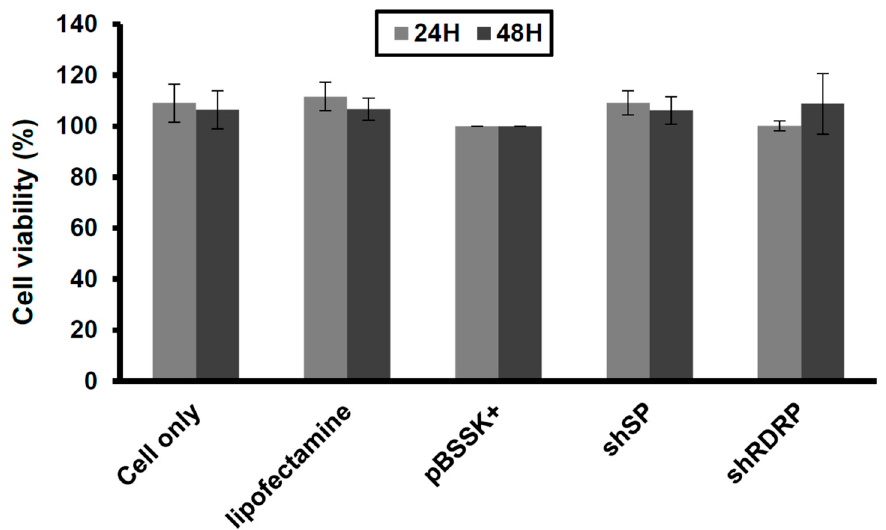
Figure 3. Overexpression of shRNA is safe in Vero-E6 cells. We transfected the cells with the shRNA constructions (pSIREN-shCoV2019SP and pSIREN-shCoV2019RdRP; 40 µg) with lipofectamine 3000 and assessed the cellular viability with a CCK-8 assay kit. We used lipofectamine and pBSSK + construction (40 µg) as a negative control and standard. Three independent experiments were performed.